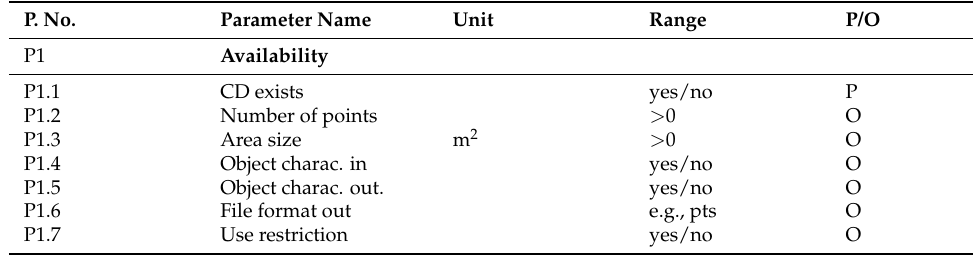
Table 5. Parameters for availability.